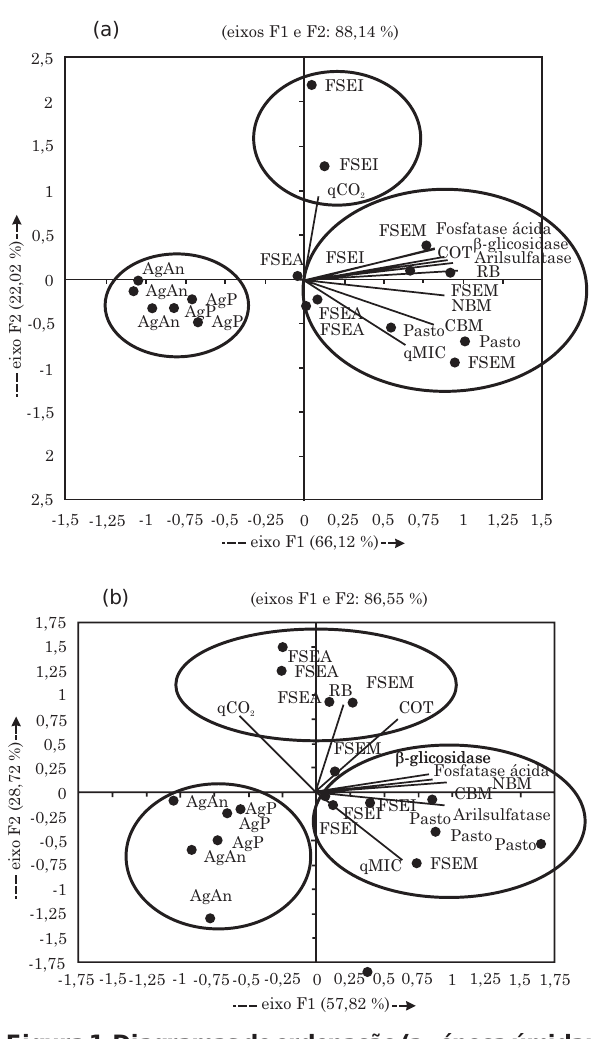
Figura 1. Diagramas de ordenação (a - época úmida; b - época seca) produzidos por análise de componentes principais dos atributos químicos (COT) e microbiológicos e das diferentes áreas em estudo. F=floresta; S=secundária; E=estádio; A=avançada; M=médio; I=inicial; Ag=agricultura; An=anual; P=perene; COT=carbono orgânico total; RB=respiração basal; qMIC=quociente microbiano; NBM=nitrogênio da biomassa microbiana; CBM=carbono da biomassa